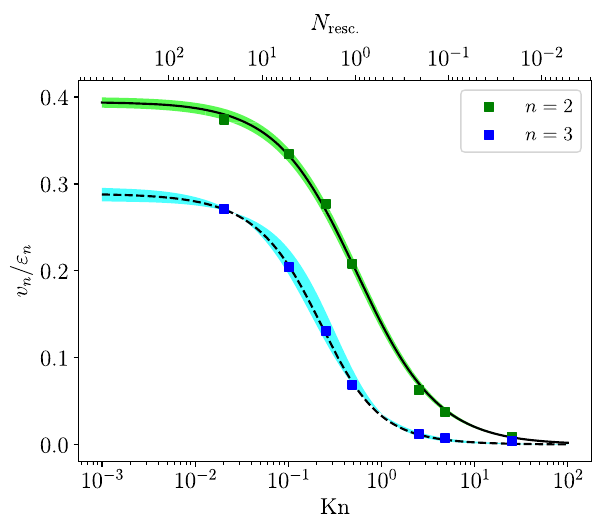
Fig. 3 v n /ε n as a function of the Knudsen number and the mean num- ber of rescatterings N resc . per particle, where v n and N resc . are estimated at time t = 100 R . The fits were performed with Eqs. (13)–(14). The colored bands show the 1 σ fit